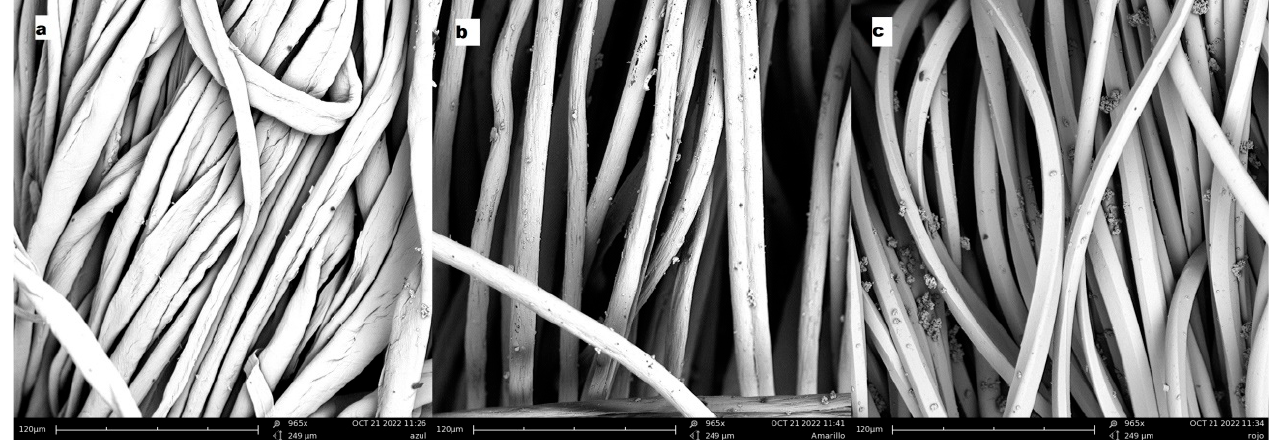
Figure 8. ( a ) SEM sample TDB199, ( b ) SEM sample TBY2, ( c ) SEM sample TDR1. Table 5. BET surface areas, pore volumes and average pore sizes. Sample Surface Area (m 2 /g) Pore Volume (cm 3